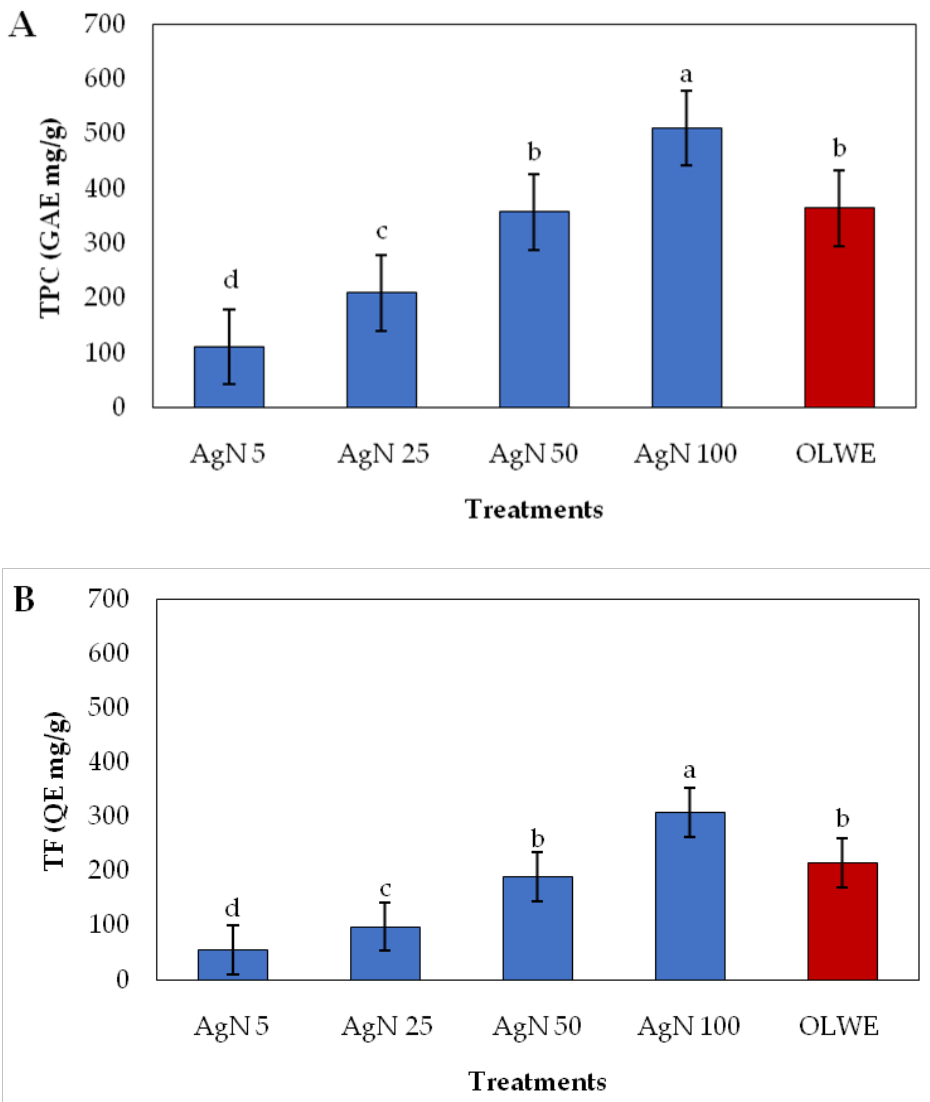
Figure 2. ( A ) The total phenolic (TPC) expressed as mg gallic acid/g and ( B ) total flavonoid content (TF) expressed as mg quercetin/g in OLAgNPs compared to OLWE. Lowercase letters above columns indicate significant differences